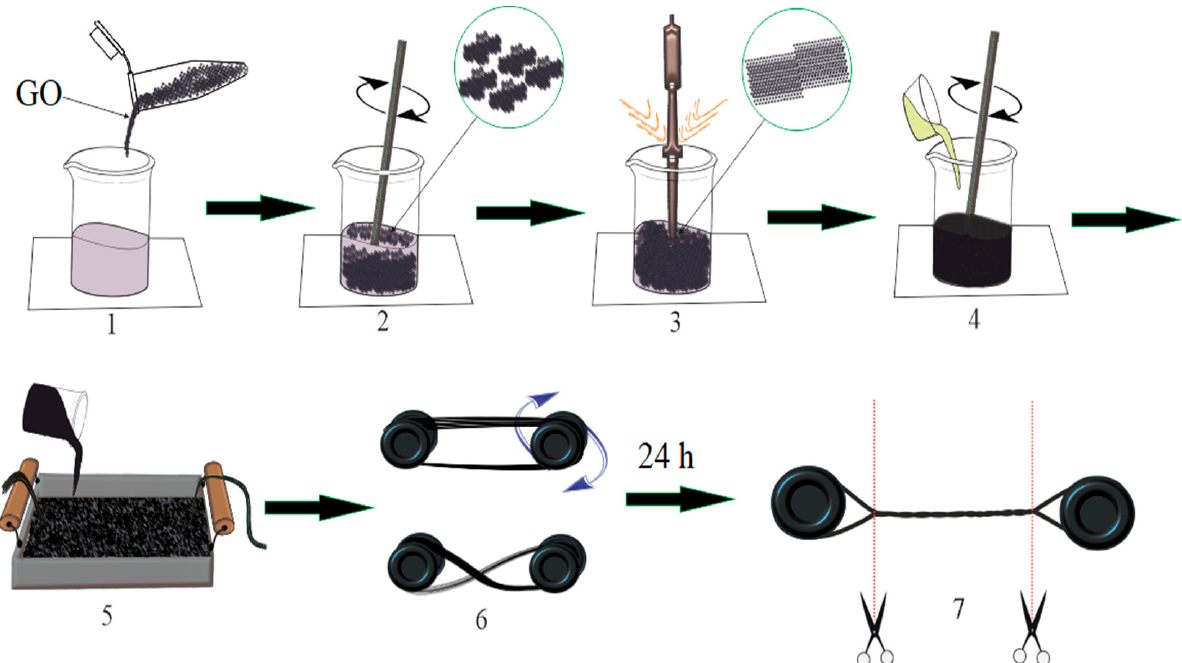
Figure 1. Scheme of obtaining a reinforced composite.